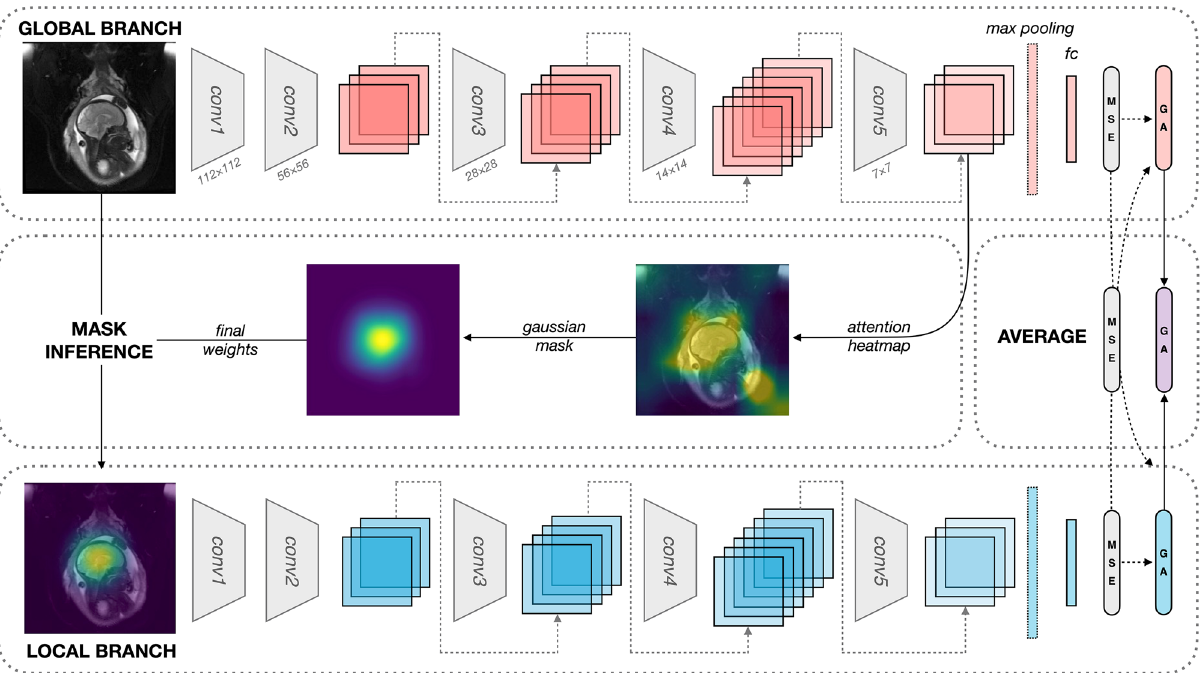
Figure 2. ResNet-50 architecture for brain age regression with attention-guided mask inference. A single sagittal image with dimensions 224 × 224 is shown as an input to the global branch. Architectures incorporating multiple slices and planes are not displayed. The input of the local branch is a weighted image isolating the region of interest automatically generated from attention-guided mask inference. Global and local branches contain five convolutional layers (conv1 to conv5), each consisting of 3–6 building blocks (boxes) with a convolution, batch normalization, and rectified linear unit (ReLU), streamlined by shortcut connections (gray dotted arrows). Output sizes are denoted by k × k . Feature maps from both branches enter a max pooling layer and are subsequently fed to a fully connected layer (fc). The MSE for each branch and the total loss are minimized via gradient descent (black dotted arrows), simultaneously tuning model weights for both local and global branches via backpropagation. Age predictions (GA) are generated from each branch and averaged to produce the final age